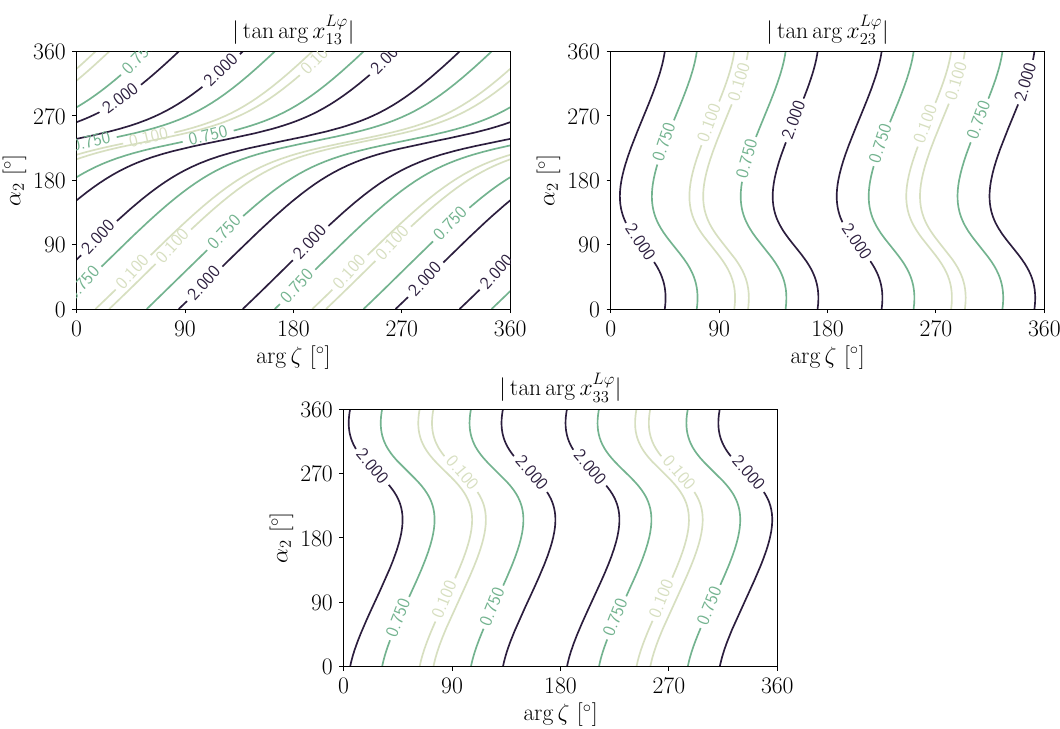
Figure 16. Contours of j tan arg x L’ j = j Im( x L’ ) = Re( x L’ ) j with varying arg (cid:16) and Majorana phase i 3 i 3 i 3 (cid:11) 2 . The index i enumerates over charged-lepton (cid:13)avours. It is clear that the choice arg (cid:16) (cid:25) (cid:25)= 2 ensures Im x L’ (cid:28) Re x L’ for the muon and tau couplings ( i = 2 ; 3). The ratio of the imaginary i 3 i 3 and real parts of the electron coupling ( i = 1) varies signi(cid:12)cantly with (cid:11) 2 . The Dirac phase and all other neutrino parameters have been set to their central values.